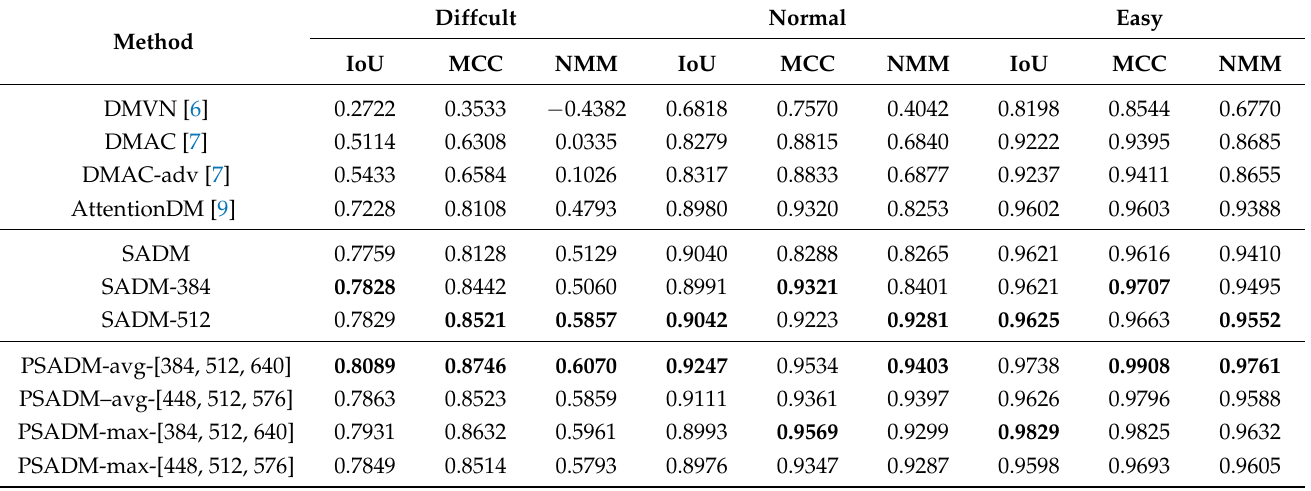
Table 3. Localization performance comparison on the generated datasets from MS COCO of SADM and PSADM.